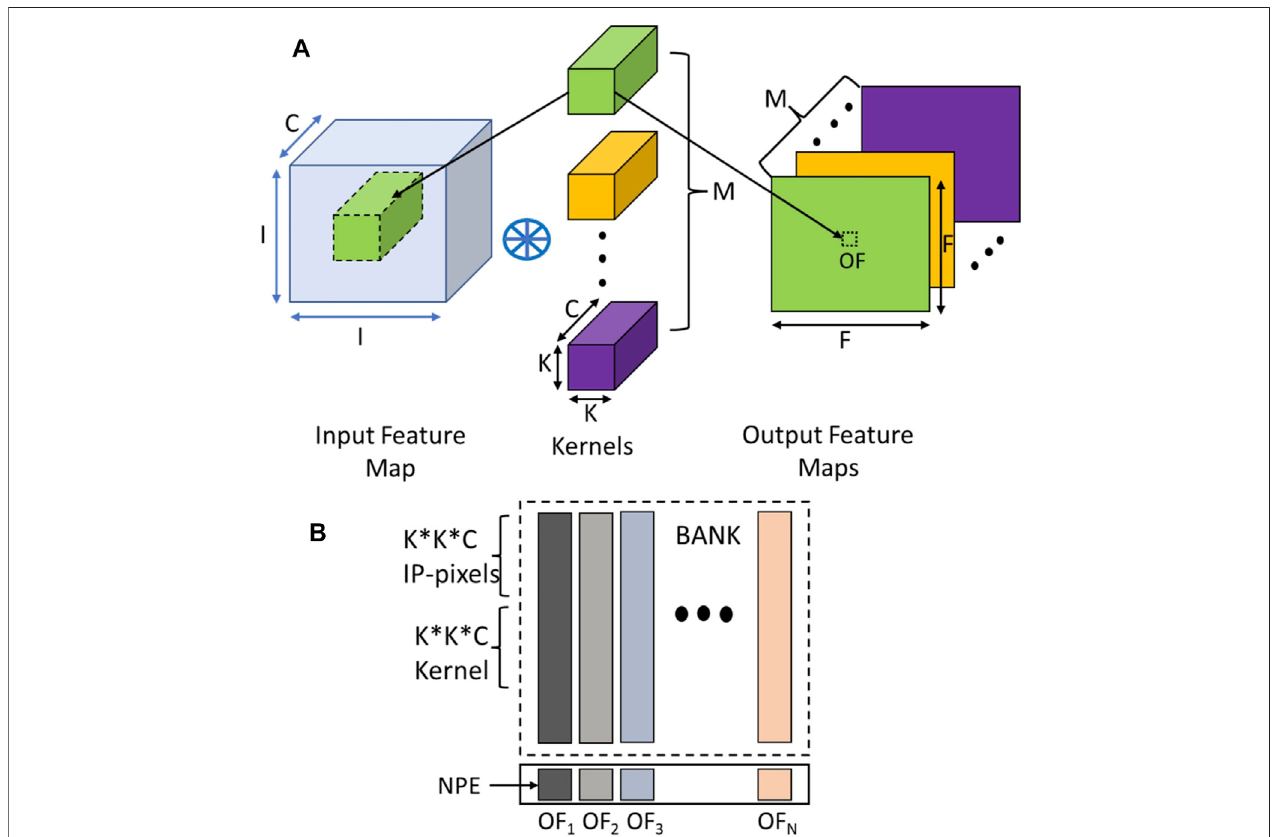
FIGURE 10 | (A) Convolution Operations with its important parameters and (B) Data mapping into DRAM banks for the Convolution layer.